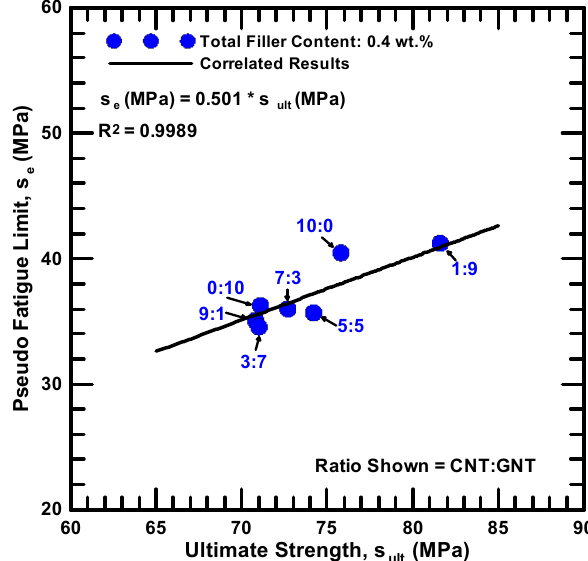
Figure 10. Relationship between the pseudo fatigue limits σ e and the ultimate strength σ ult for the studied nanocomposites with various filler ratios.